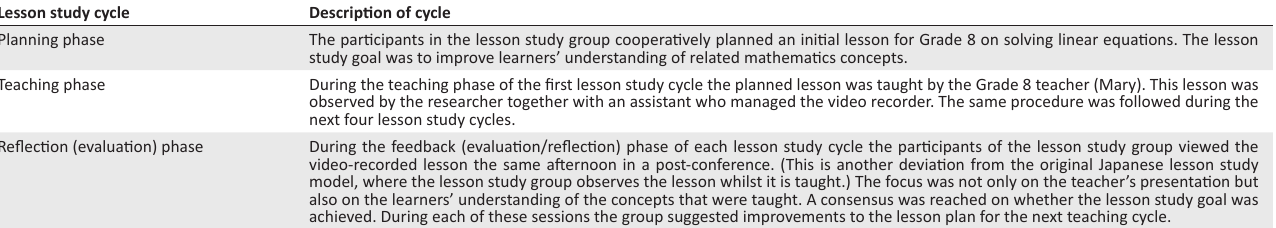
TABLE 2: Procedure for data